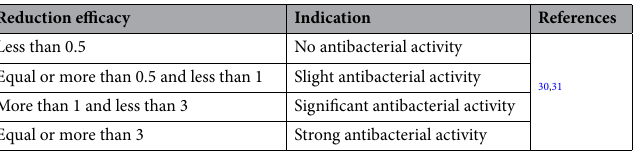
Table 1. Assessment guide of antibacterial activities (reduction) of face masks coated with TiO2 nanoparticles.